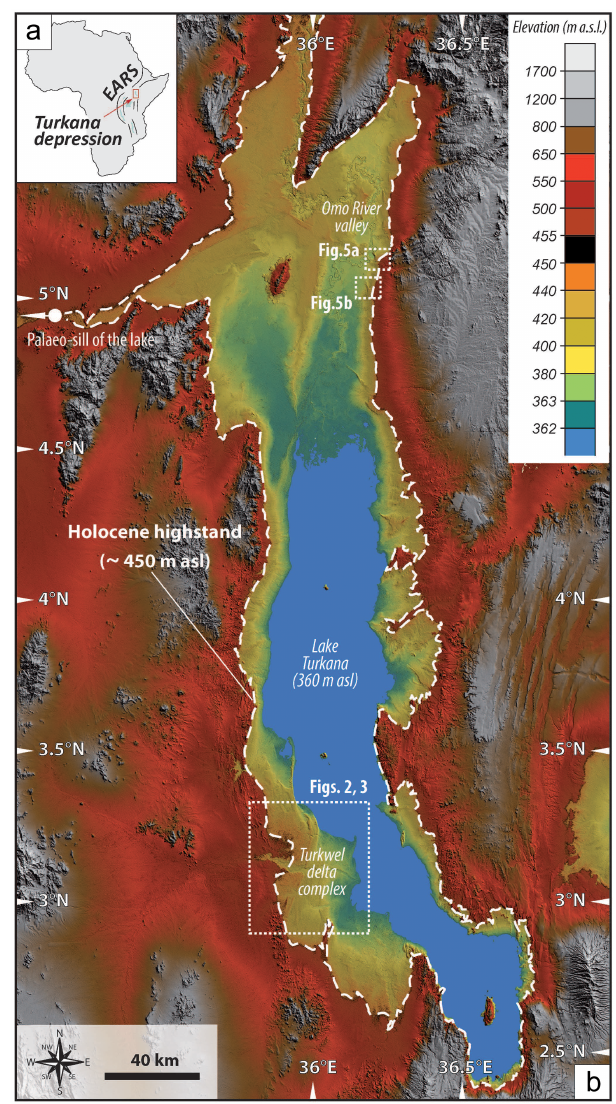
Figure 1. Location maps. (a) Lake Turkana basin in the East African Rift system (EARS). (b) Digital elevation model (DEM) SRTM1 showing Lake Turkana and the two investigated areas (Turkwel delta complex and the east side of the Omo River valley). Dashed white line represents the maximum Holocene lake level. All described geomorphological features are located between the palae- olake limit and the modern lake